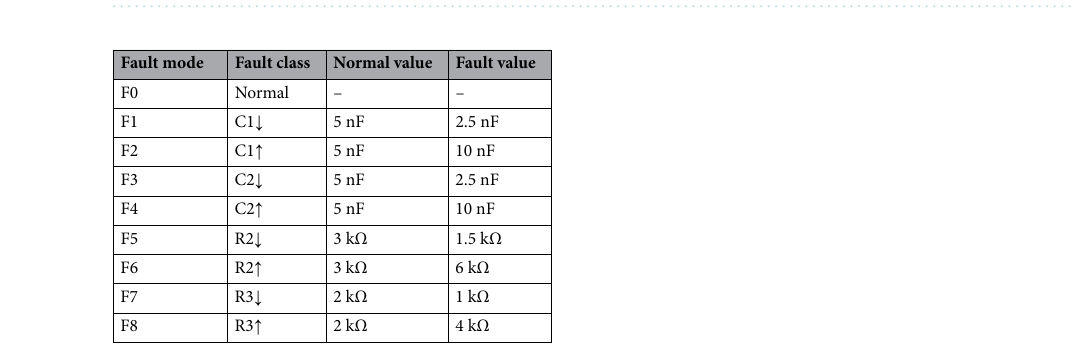
Figure 4. ( a ) Schematic of Sallen–Key bandpass filter circuit (Case 1); ( b ) Schematic of four-op-amp biquad highpass filter circuit (Case 2).